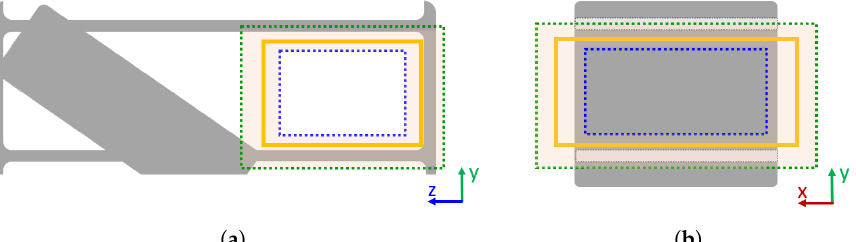
Figure 6. The detected bounding box is depicted with an orange rectangle. Dilating or contracting that bounding box by d v would create green or blue bounding boxes, respectively. The highlighted volume between the blue and green bounding boxes contains mesh vertices that enclose the observed storage volume: ( a ) Front view, ( b ) Side view.